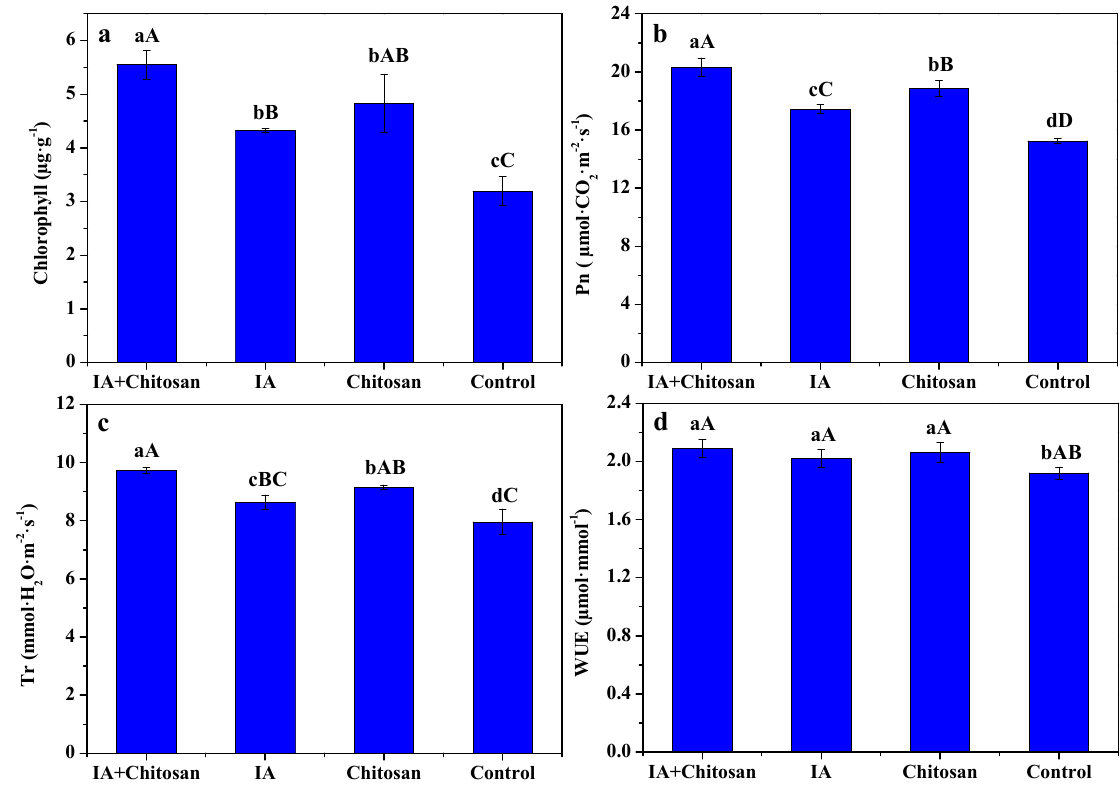
Figure 2. The effects of isopyrazam · azoxystrobin and chitosan on the chlorophyll ( a ), photosynthetic rate ( b ), transpiration rate ( c ), and water use efficiency ( d ) of kiwifruit leaves. Values and error bars indicate the mean and SD of three replicates, respectively. IA—isopyrazam · azoxystrobin. Different small and capital letters indicate significant differences at 5% level ( p < 0.05) and 1% level ( p < 0.01),